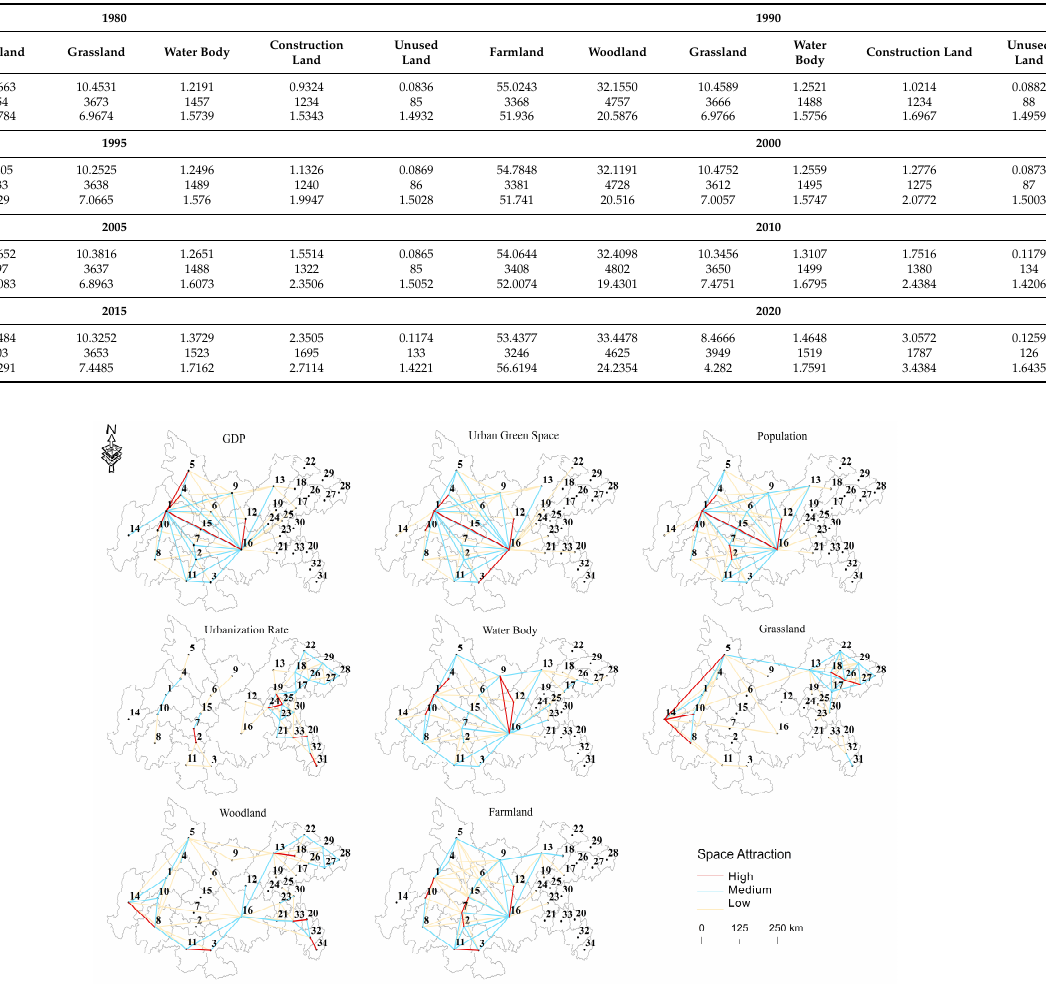
Table 5. Results of landscape pattern metrics at the class level.